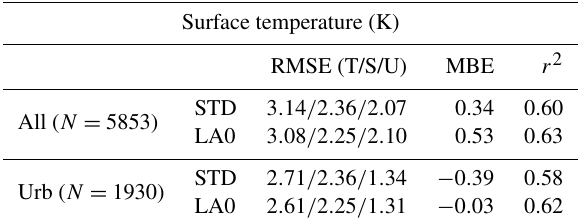
Table 7. RMSEs, MBEs and r 2 of the simulated (STD) LST (K) against the Landsat 7 satellite observations on the 5 July 2015 at approximately 11:10LT (10:10UTC). In addition to the total RM- SEs (T), the systematic (S) and the unsystematic (U) RMSEs are listed. “Urb” represents the comparison only at the urban grid cells ( f urb > 0 . 1). Grid cells contaminated by water or clouds have been removed. Surface temperature (K) RMSE (T/S/U) MBE r 2 STD All ( N = 5853) Urb ( N =